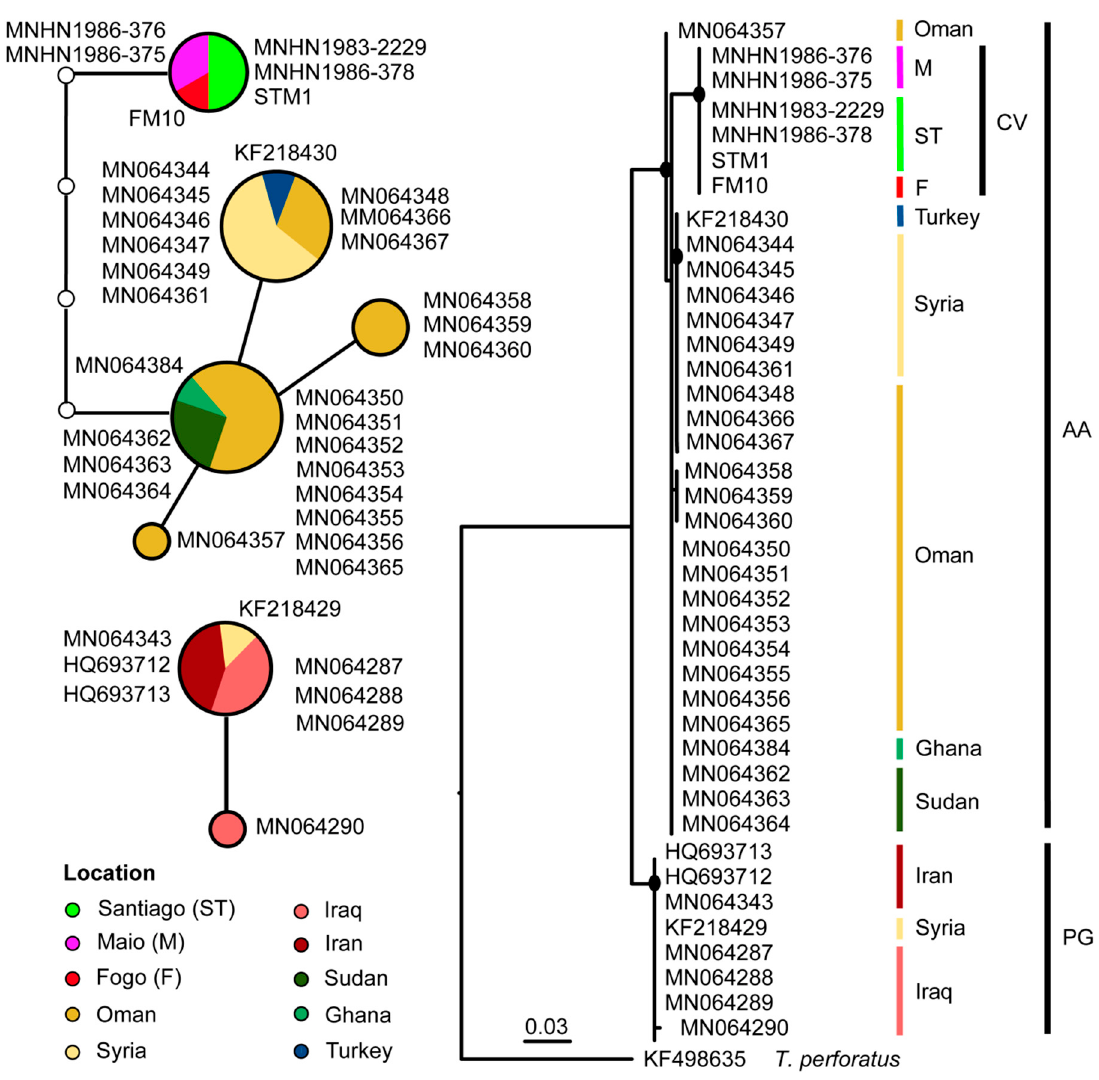
Figure 5. Parsimony network corresponding to the cyt b mtDNA sequences in Taphozous nudiventris . Lines represent mutational steps, circles indicate haplotypes, and dots show missing haplotypes. The size of the circle is proportional to the number of individuals, and different colors correspond to different locations. The evolutionary history was inferred by using the maximum likelihood (ML) phylogenetic tree rooted with T. perforatus (outgroup). Black dots on the nodes indicate ML bootstraps values ≥ 70. Clades (M, Maio; ST, Santiago; F, Fogo; CV, Cabo Verde; AA, Afro-Arabian clade; PG, Persian Gulf clade) are colored according to their geographic location. For further details on the samples, see Figure 1, Tables S1 and S3.